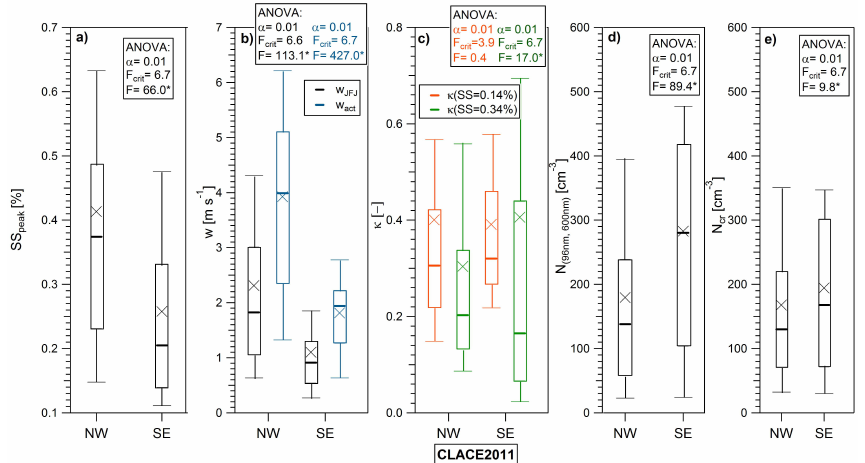
Fig. 8. Dependence of various parameters on wind direction for cloud periods (LWC 30th percentile > 5mgm − 3 ) during CLACE2011: (a) the effective peak supersaturation. (b) Updraft velocity measured at the Jungfraujoch and the retrieved updraft velocity at the point of activation. (c) Hygroscopicity parameter (retrieved from the CCNC measurements for two example SS). (d) The cloud droplet residual particle number concentration. (e) The number concentration of particles in the size range of 96nm (median D act of CLACE2011) to 600nm (upper limit of the SMPS). The 10th, 25th, 50th (median), 75th and 90th percentiles and mean value (x) of each parameter are shown. A “ ∗ ” behind the F values denotes that the ANOVA indicates a significant difference between the mean values of a parameter for northwestern and southeastern wind